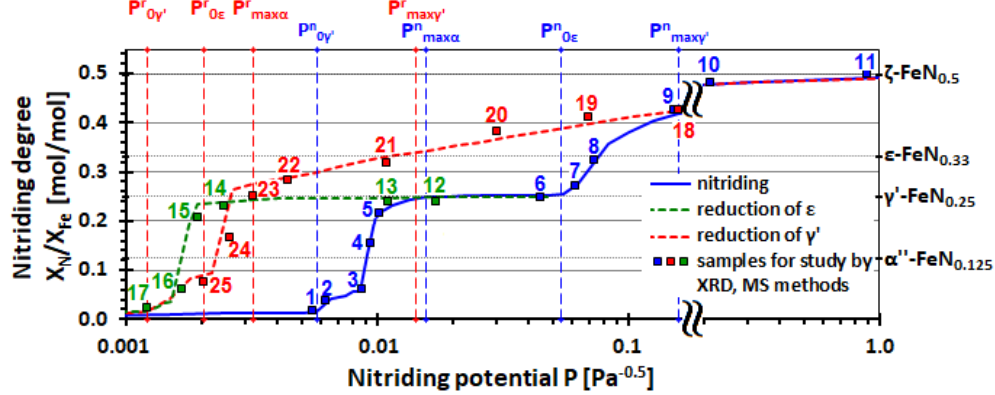
Figure 7. The dependence of the nitriding degree on nitriding potential, P, in the iron nitriding process (solid line) and nanocrystalline iron nitride reduction (dashed lines) at stationary states (350 °C): superscripts n and r —nitriding and reduction, respectively; α, γ’, and ε— the designation of the phases of α - Fe(N), γ’ -FeN 0.25 , and ε -FeN x , respectively; subscripts 0 and max — the minimum and maximum nitriding potential, respectively, at which the phase exists [27].